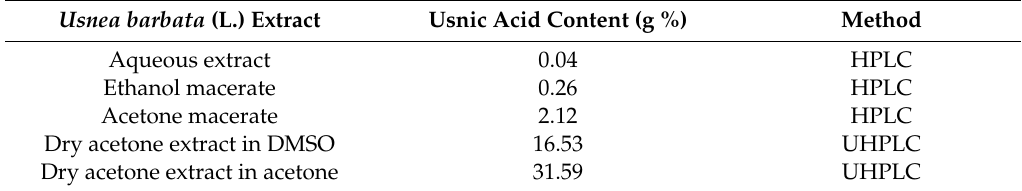
Table 1. Usnic acid content (g %) in various extracts of Usnea barbata (L.) F. H. Wigg. Usnea barbata (L.) Extract Usnic Acid Content (g